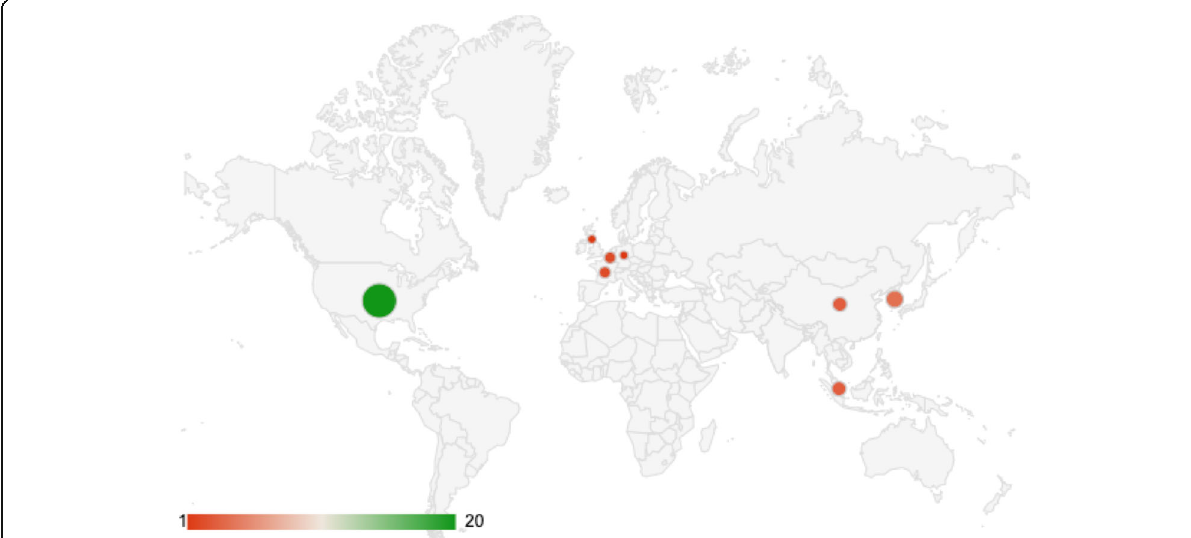
Fig. 2 Geographical distribution of articles publications. The USA is the main country where publications came from, followed by China and